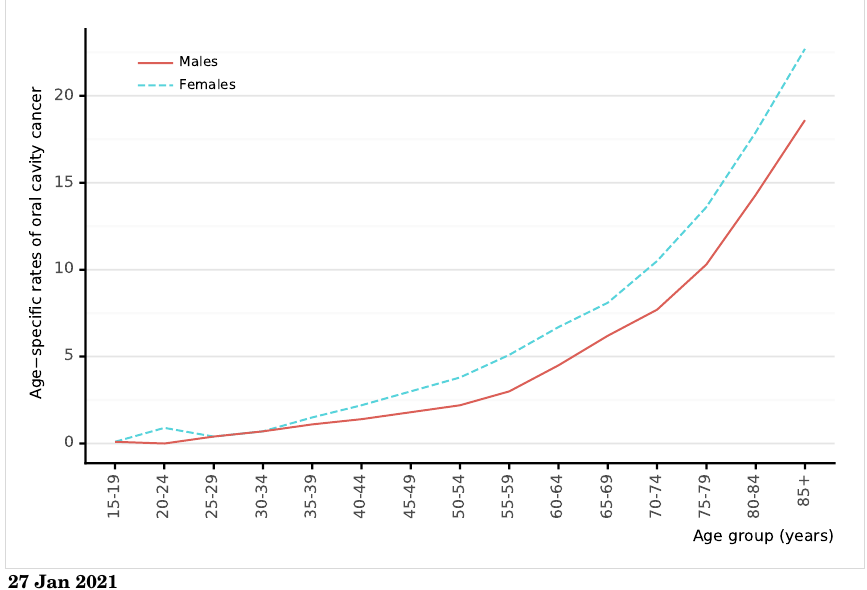
Figure 42: Age-specific incidence rates of oral cavity cancer in Peru (estimates for 2020)